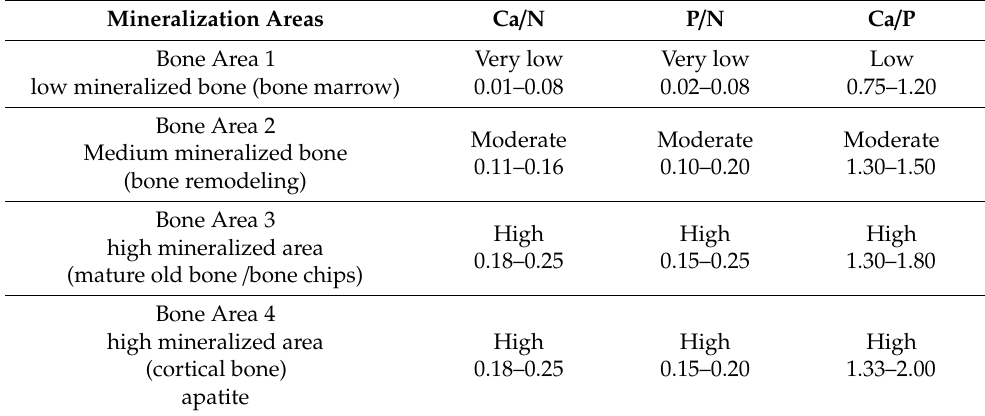
Table 2. Range of EDX atomic ratio of Ca / N P / N and Ca / P of the analyzed areas of